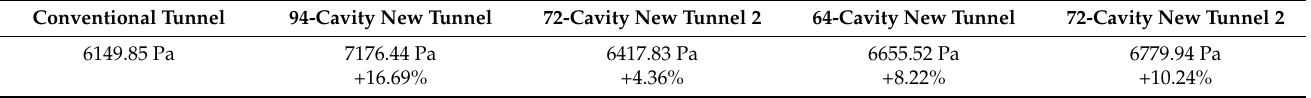
Table 4. Comparison of pressure variations at the tunnel wall for different